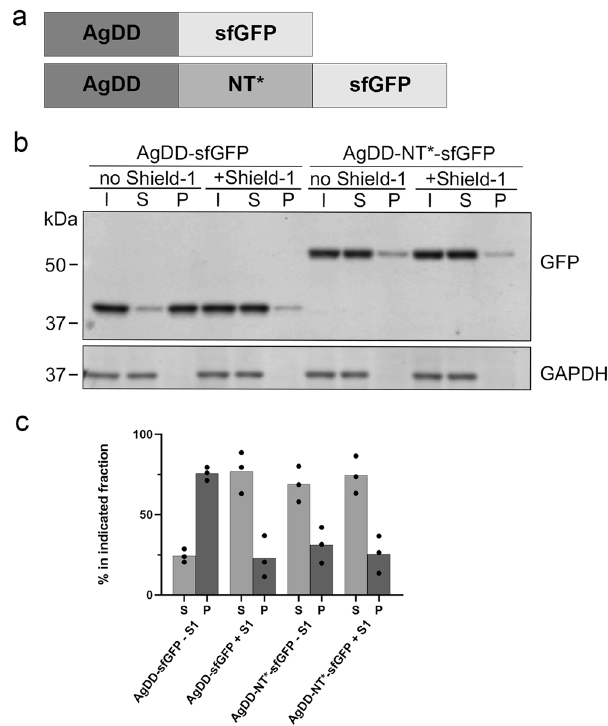
Fig. 1 Spider NT* domain prevents ligand-regulatable aggregation in human cells. a Schematic representation of the fusion protein AgDD-sfGFP and AgDD-NT*-sfGFP. b HeLa cells were transiently transfected with AgDD-sfGFP or AgDD-NT*-sfGFP, incubated in the absence or presence of 1 µ M Shield-1 and fractionated into Triton X-100 soluble (S) and Triton X-100 insoluble/SDS soluble (P) fractions. (I) shows the whole cell lysate/ input before fractionation. Western blots were probed with antibodies directed against GFP and GAPDH. c Quanti fi cation of the relative distribution of the GFP band in the soluble and insoluble